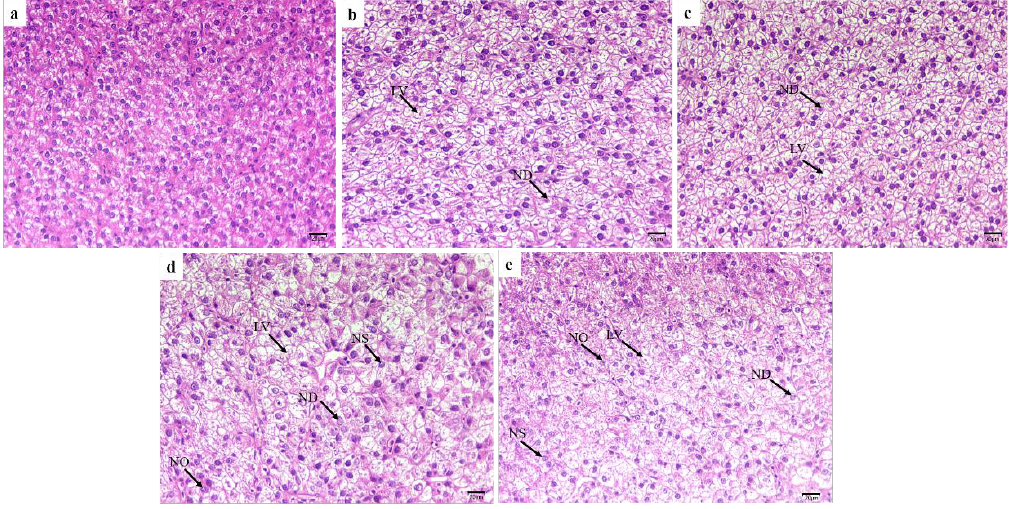
Figure 3. H&E-stained sections of liver from hybrid yellow catfish fed with different glycinin levels. ( a ), the control; ( b ), 2% glycinin; ( c ), 4% glycinin; ( d ), 6% glycinin; ( e ), 8% glycinin. LV: lipid vacu- oles; ND: nuclear dissolution; NS: nuclear shrinkage; NO: nuclear offset. Magnification was 400×, and the scale represents 20 μm.